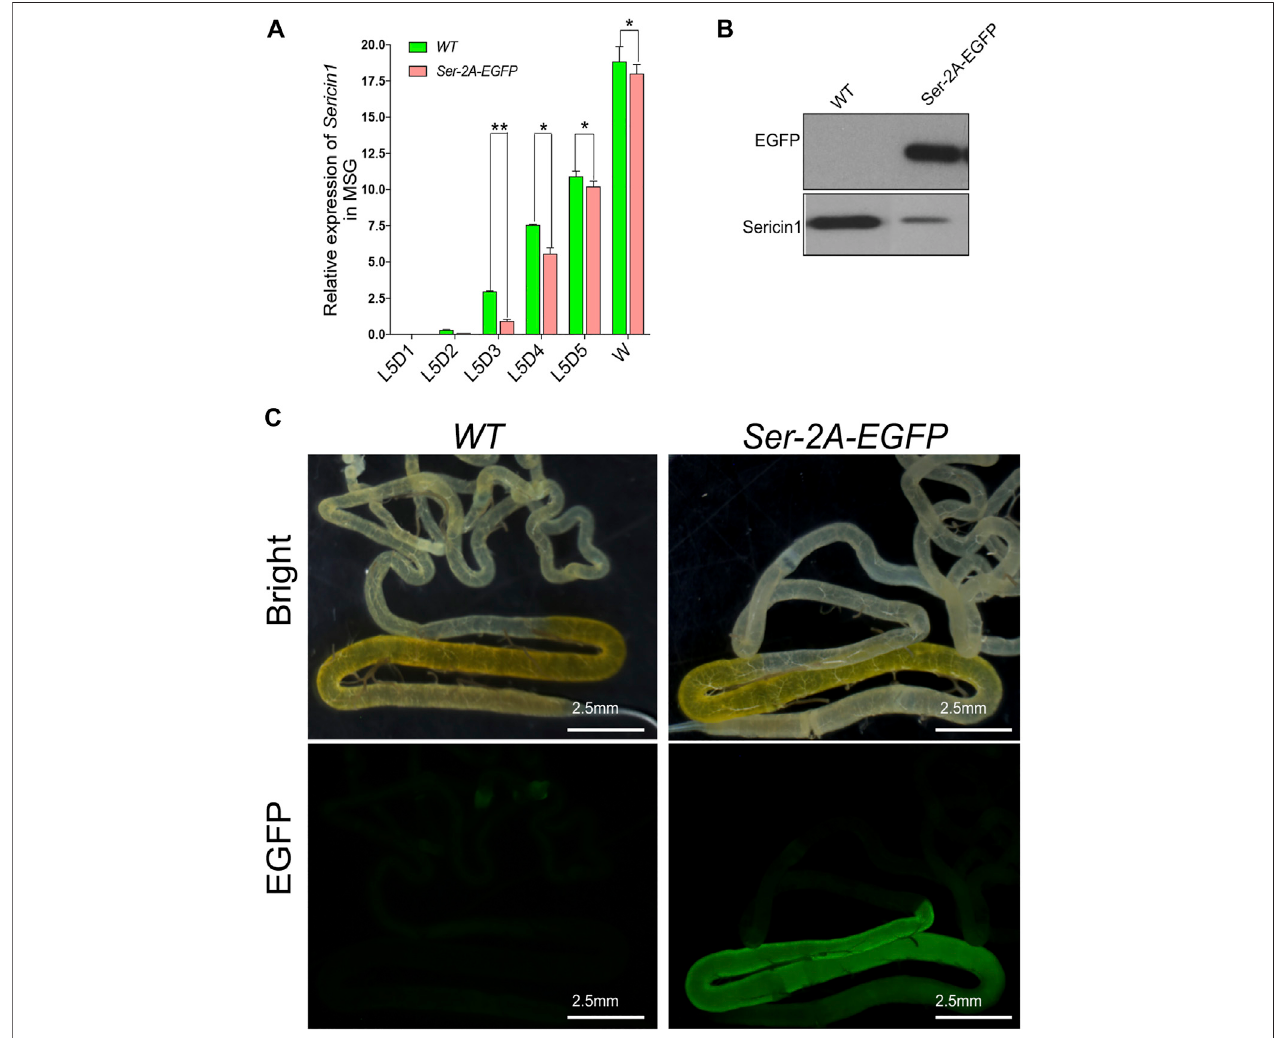
FIGURE 3 | High production of enhanced green fl uorescent protein (EGFP) protein by 2A mediated Sericin – EGFP in-fusion expression. (A) Relative transcriptional levelof Sericin1 in WT and Ser – 2A – EGFP silkworms.qRT-PCRwasusedtoquantifythetranscriptionallevelof Sericin1 and EGFP in (A) and (B) .Thesilkworm ribosome protein49 ( Bmrp49 )orthologwasusedastheinternalreference.ThreeindividualreplicateswereusedforqRT-PCR,andtheerrorbarsrepresentthemean ± S.E.M. (B) Western blotting of EGFP and Sericin1 protein in the middle silk gland (MSG) of wild-type (WT) and Ser – 2A – EGFP silkworms at the wandering stage. (C) Fluorescence observation of the silk gland in the MSG of WT and Ser – 2A – EGFP silkworms. Silk glands were extracted from the day 3 ofthe fi fth instar larvae. Error bars stand for 2.5